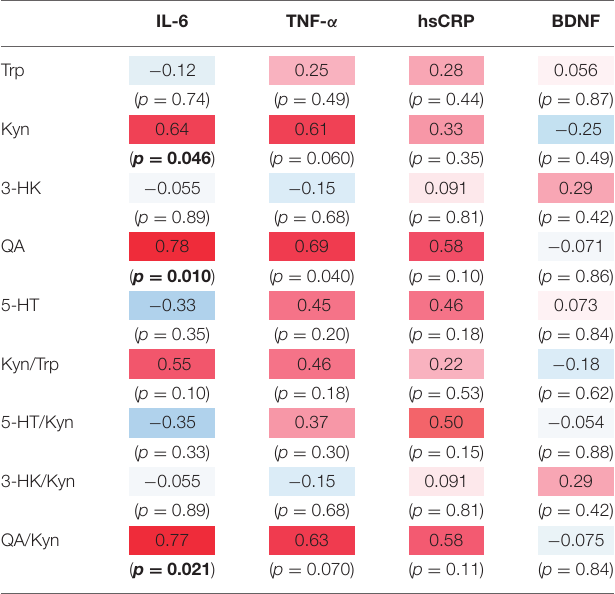
TABLE 4B | Relationship between metabolites of the Kyn pathway and cytokines, hsCRP, and BDNF in the healthy control group.